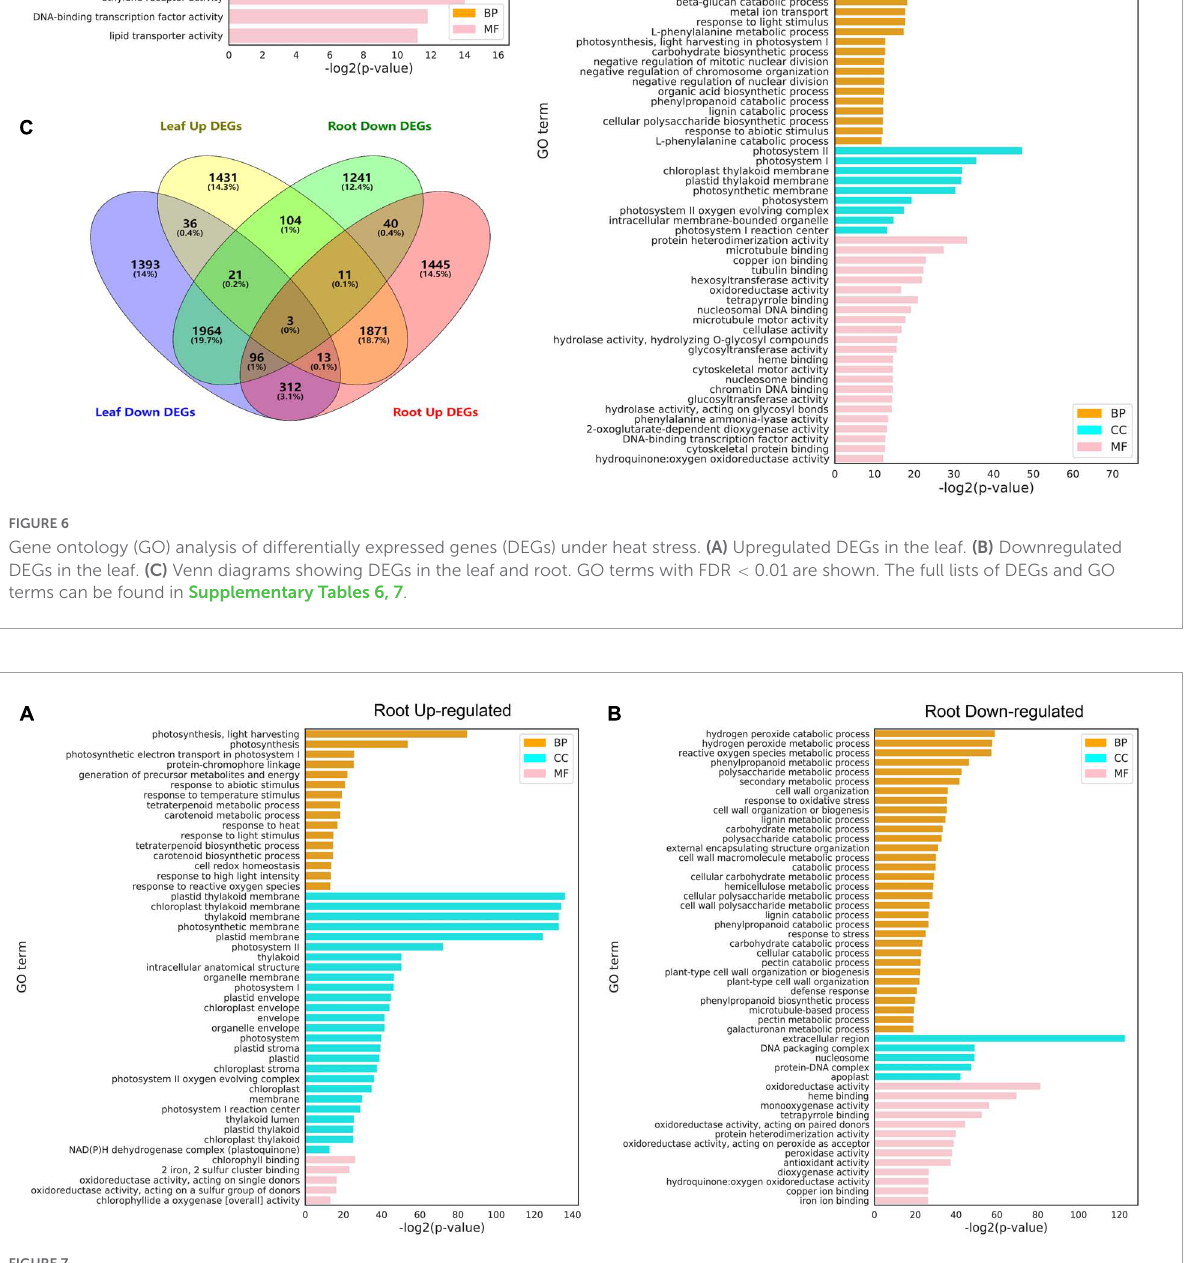
FIGURE7 Gene Q20 ontology (GO) analysis of differentially expressed genes (DEGs) under heat stress. (A) Upregulated DEGs in the root. (B) Downregulated DEGs in the root. GO terms with FDR < 0.01 are shown. CC: cellular component; MF: molecular function; BP: biological process. The full lists of DEGs and GO terms can be found in Supplementary Tables 8, 9